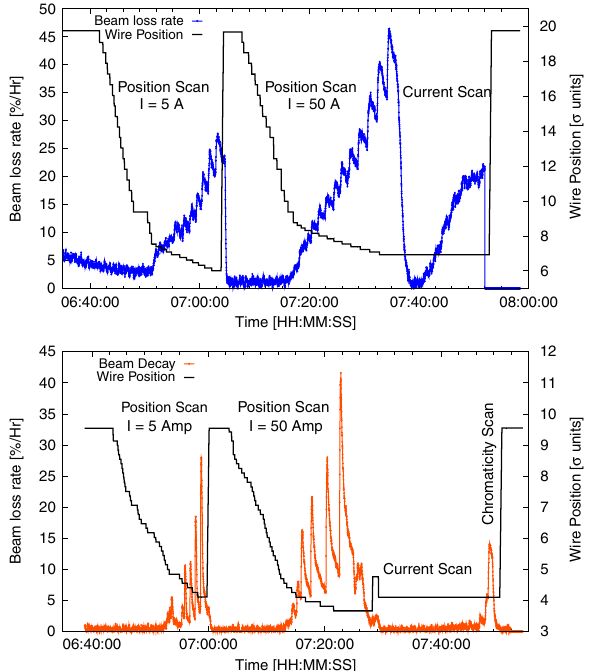
FIG. 10. Beam losses and wire position as a function of time during the course of position and current scan (May 2007, fill 8727).